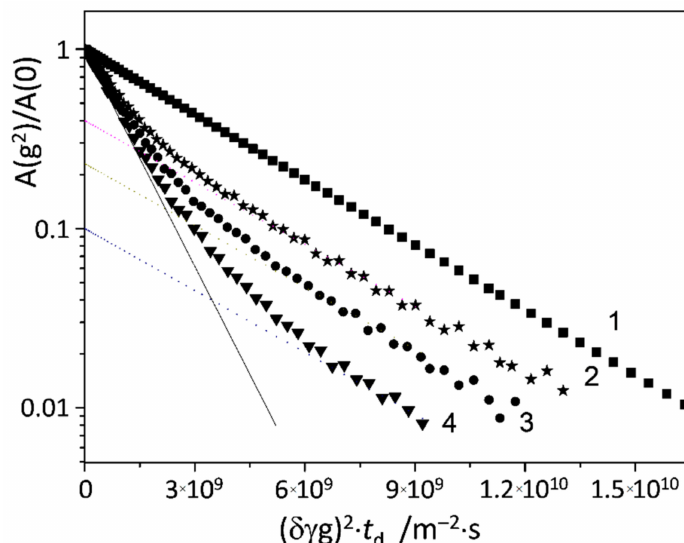
Figure 8. Di ff usion attenuations of spin–echo signals for the anomeric CH proton of β -CD (1) and H6 proton of 5-FU (2, 3, 4). The di ff usion time t d was 7 ms (curves 1 and 2), 15 ms (curve 3) and 25 ms (curve 4). Dashed lines correspond to Equation (4). Solid line corresponds to the initial slope of curves 2, 3 and 4, which determine the average di ff usion coe ffi cient value for 5-FU. The sample